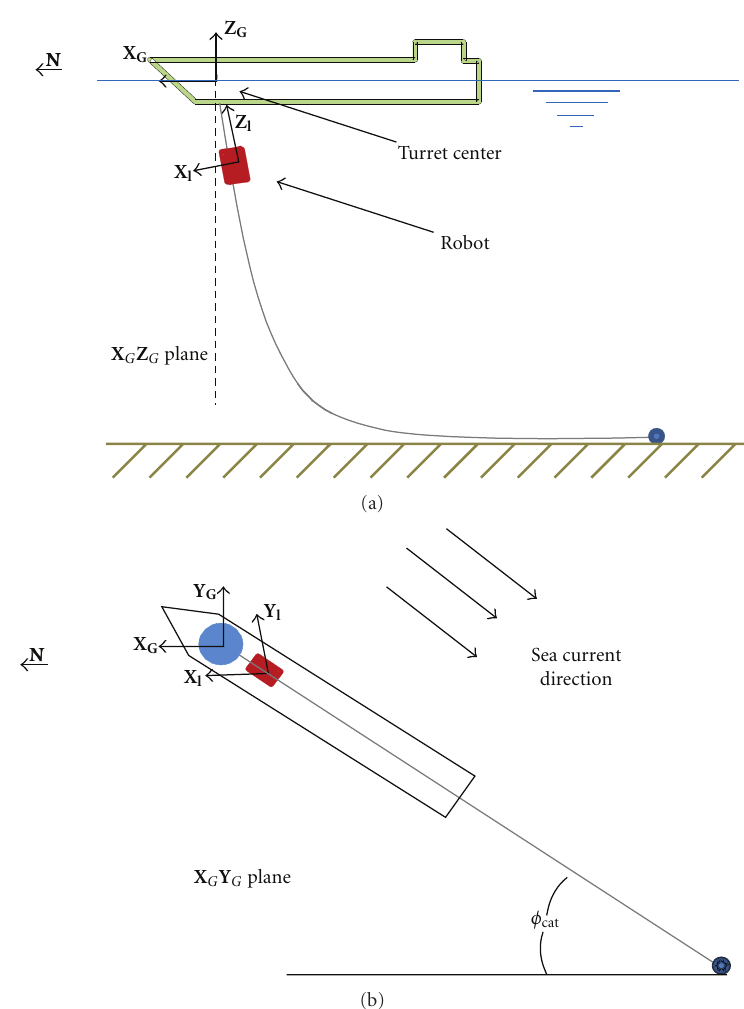
Figure 5: Side and upper views of the FPSO and riser configuration. Global ( X G , Y G , Z G ) and local ( X l , Y l , Z l ) reference systems position and orientation are shown. The FPSO and riser catenary plane are considered as being aligned with the sea current, forming an angle φ cat with the X G direction in X G Y G